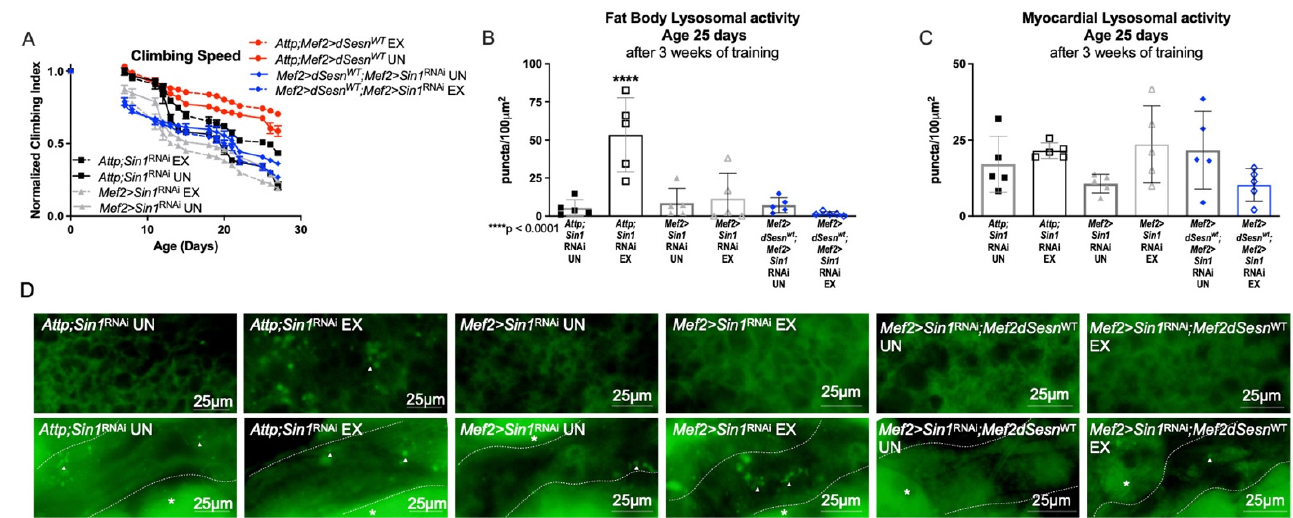
Figure 6. Sestrin-dependent adaptations in climbing speed and lysosomal activity depend on the TORC2 axis. ( A ) Flies expressing muscle specific RNAi against Sin1 ( Mef2 > Sin1 RNAi) reduce climbing speed with exercise (2-way ANOVA, exercise effect, p ≥ 0.0268). Muscle-specific wild-type dSesn expression ( Mef2 > dSesn WT ; Mef2 > Sin1 RNAi flies) does not rescue climbing speed. Climbing speed experiments performed in triplicate, n ≥ 100 flies. ( B ) Mef2 > dSesn WT ; Mef2 > Sin1 RNAi flies have low fat body Lysotracker staining whether exercised or not. ( C ) Myocardial Lysotracker staining is similar across genotypes independent of exercise and wild-type dSesn expression in flies with muscle specific RNAi against Sin1 . ( D ) Representative 63× images of Lysotracker staining from fat body (upper panels, quantified in ( B )) and myocardium (lower panels, quantified in ( C )). Lysotracker staining n = 5, performed in duplicate or triplicate. Dotted lines in myocardial images delineate heart tissue. White triangles point to example regions of Lysotracker puncta. White asterisks indicate pericardial cells. Asterisks in histograms indicate significant pairwise post-hoc comparisons from ANOVA. Error bars depict ± SD. EX = cohort after 3 weeks of ramped, daily endurance training. UN = control unexercised flies exposed to identical training environment without running.